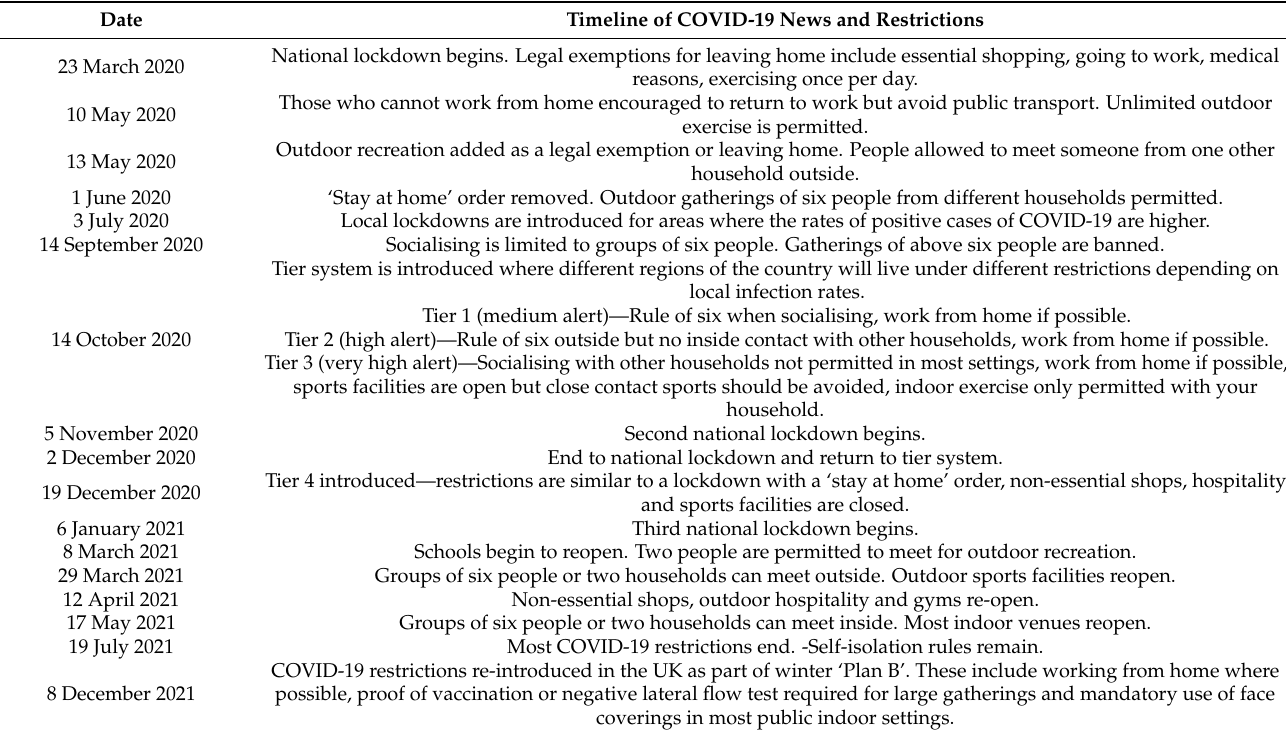
Table 1. Timeline of COVID-19 restrictions in England 2020–2021. Restrictions were similar across all countries within the UK, but dates and precise details may vary. This table was created